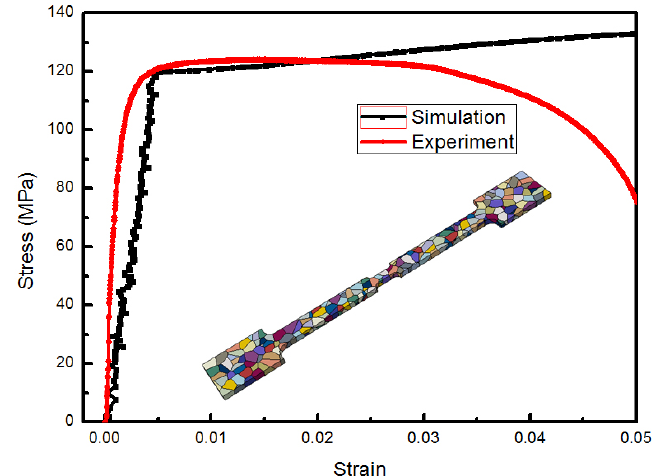
Table 1. Constitutive model parameters of pure aluminum.